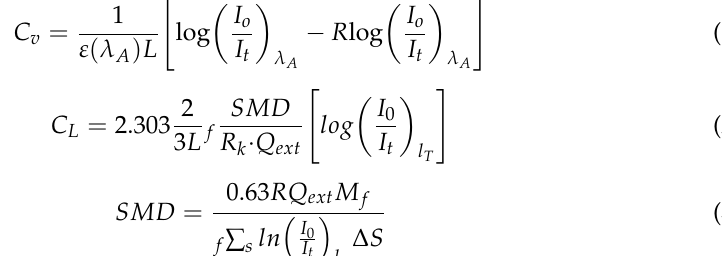
Figure 1. Principle of the C-LAS technique. However, to measure the spatial distribution of vapor and liquid concentration, the onion peeling is applied to the vapor and liquid phase optical thickness for the case of axisymmetric spray [22]. The radial cross section of the spray is divided into many concentric rings in the processing model. When each ring’s width is extremely narrow, the concentrations within the ring can be termed homogeneous. The concentration of vapor phase fuel in each ring can be calculated through Lambert–Beer’s law by Equation (1). For liquid concentration, it is assumed that liquid droplets in the spray have a uniform Sauter Mean Diameter ( SMD ). Based on droplet optical thickness and light scattering theory, the concentration of the liquid can be determined as shown in Equation (2). The SMD is measured by summing the liquid droplet optical thickness in the whole extinction image of the spray.